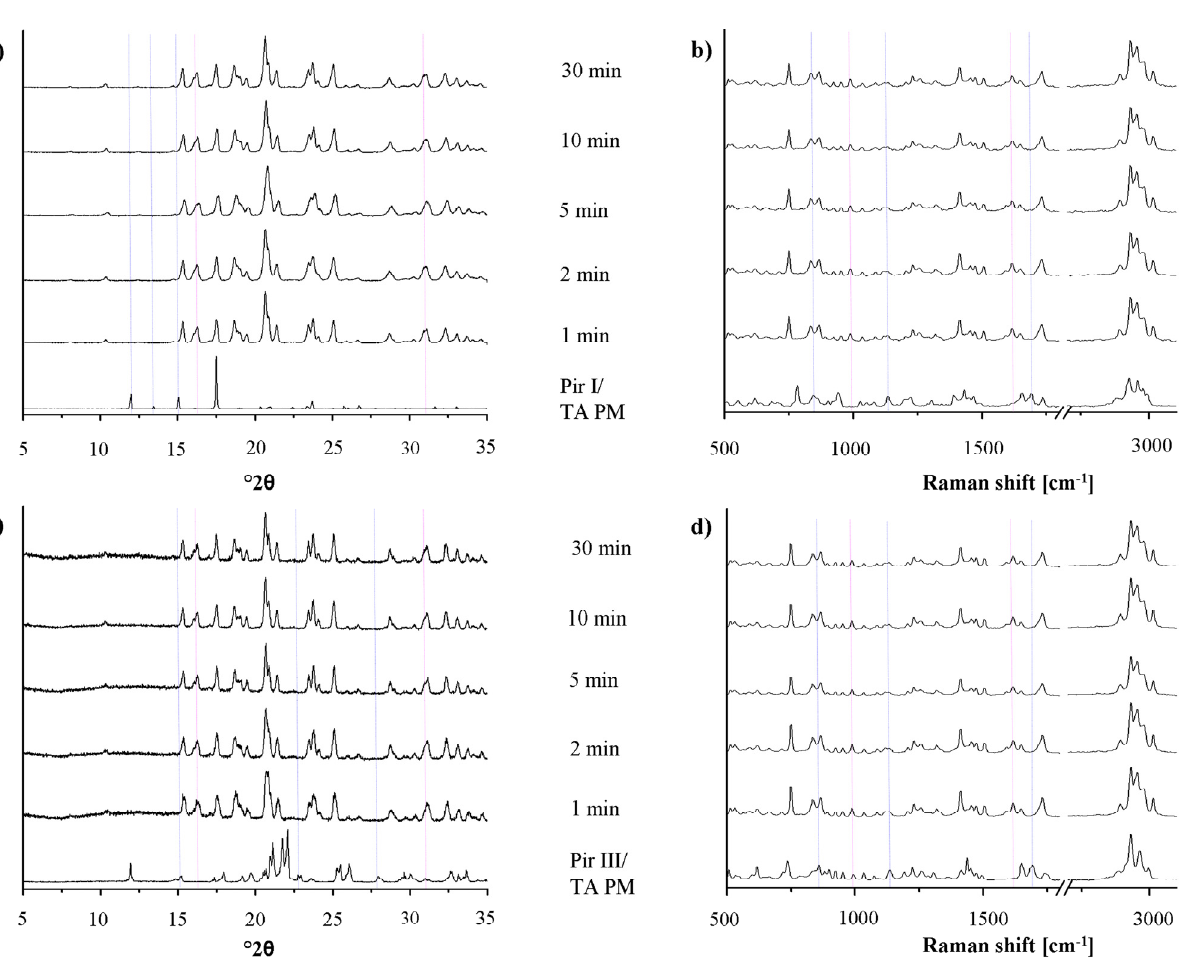
Figure 9. ( a ) XRPD patterns of the physical mixture of piracetam form I and tartaric acid (Pir I/TA PM), after liquid-assisted grinding for predefined time periods. ( b ) Raman spectra of the physical mixture of piracetam form I and tartaric acid (Pir I/TA PM), after liquid-assisted grinding for predefined time periods. ( c ) XRPD patterns of the physical mixture of piracetam form III and tartaric acid (Pir III/TA PM), after liquid-assisted grinding for predefined time periods. ( d ) Raman spectra of the physical mixture of piracetam form III and tartaric acid (Pir III/TA PM), after liquid-assisted grinding for predefined time